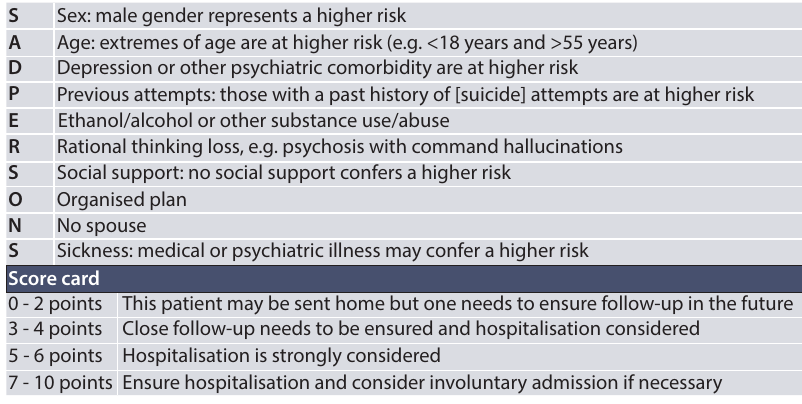
Fig. 3. ‘SAD PERSONS’ scale (yes for any letter = 1